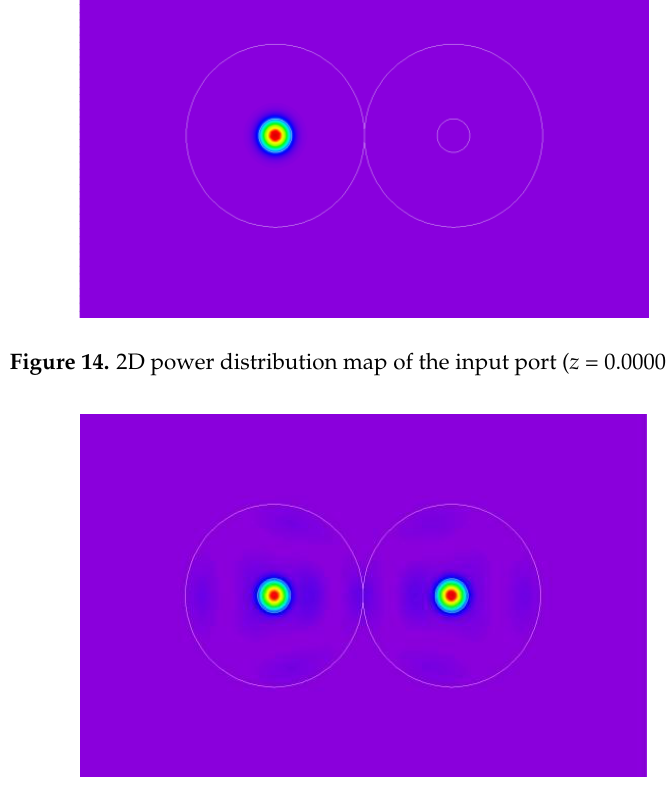
Figure 16. 2D power distribution map for the output port ( z =9910.7982 μm).